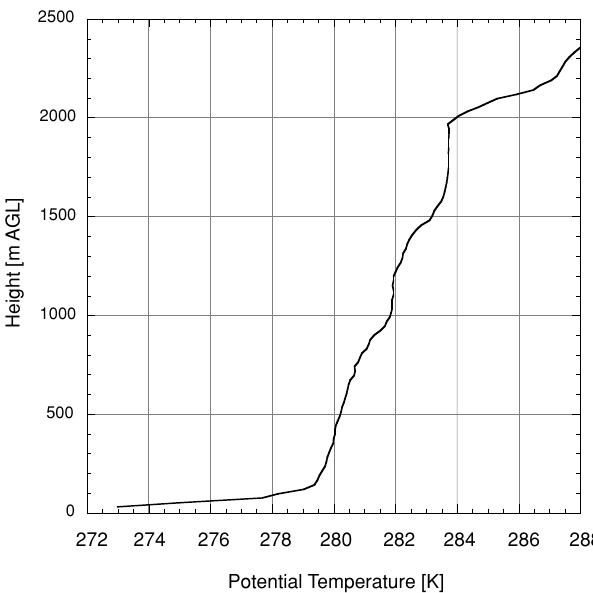
Fig. 13. Profile of potential temperature ( θ ) derived from an AO radiosonde observation at 20:30 JST on 29 December 1997.